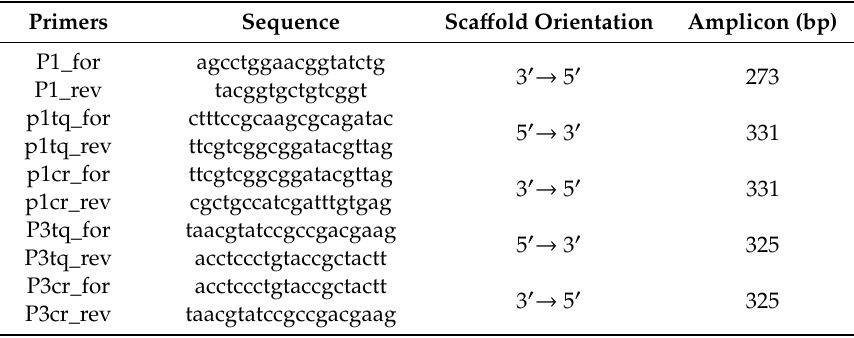
Table 1. Primers used to investigate putative herpesvirus DNA polymerase sequence obtained through next-generation sequencing